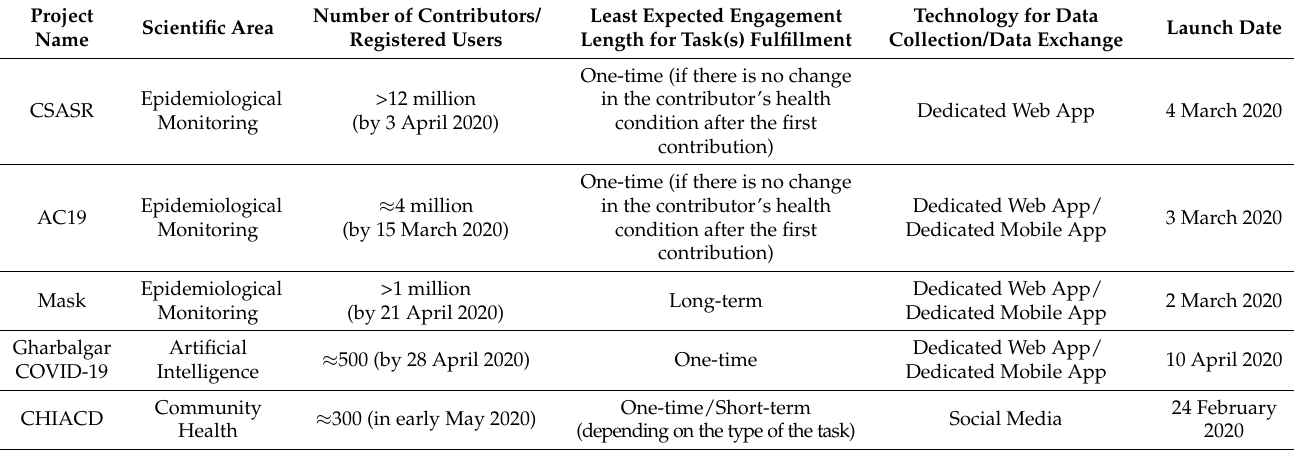
Table 1. The general specifications of five identified Iranian COVID-19-related online citizen science